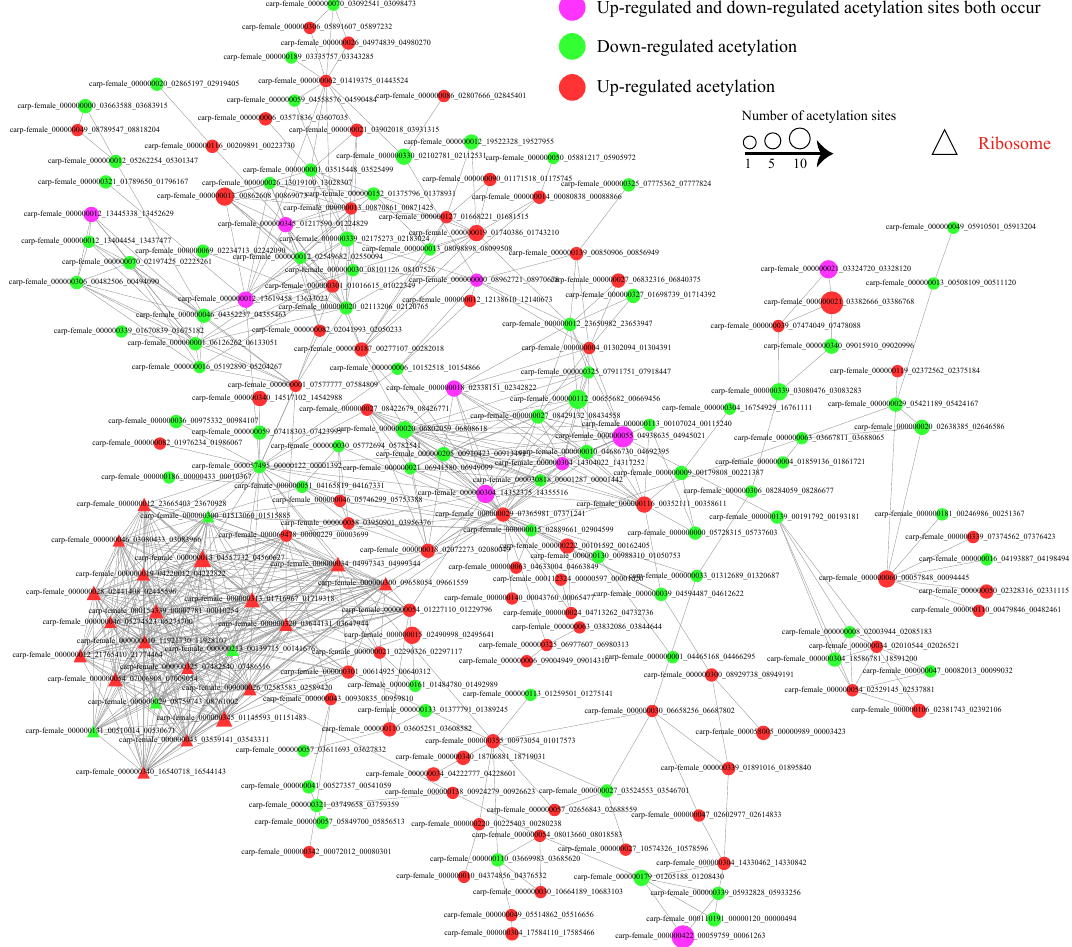
Figure 6. Interaction network of the quantified lysine acetylated proteins. The proteins associated with ribosome were shown in “ (cid:52) ”. The proteins in green are down-regulated and the proteins in red are up-regulated. Proteins in purple were modified at different sites with both increased and decreased